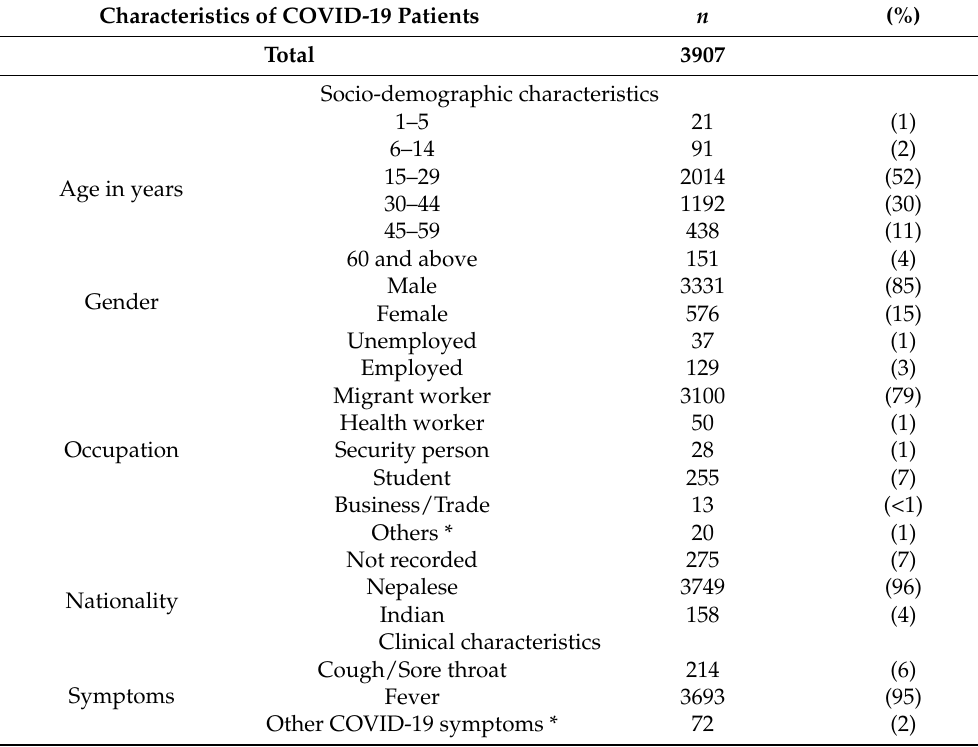
Table 2. Socio-demographic and clinical characteristics of patients diagnosed positive for COVID-19 at 13 POE in Nepal: 19 March 2021–15 July 2021. Characteristics of COVID-19 Patients